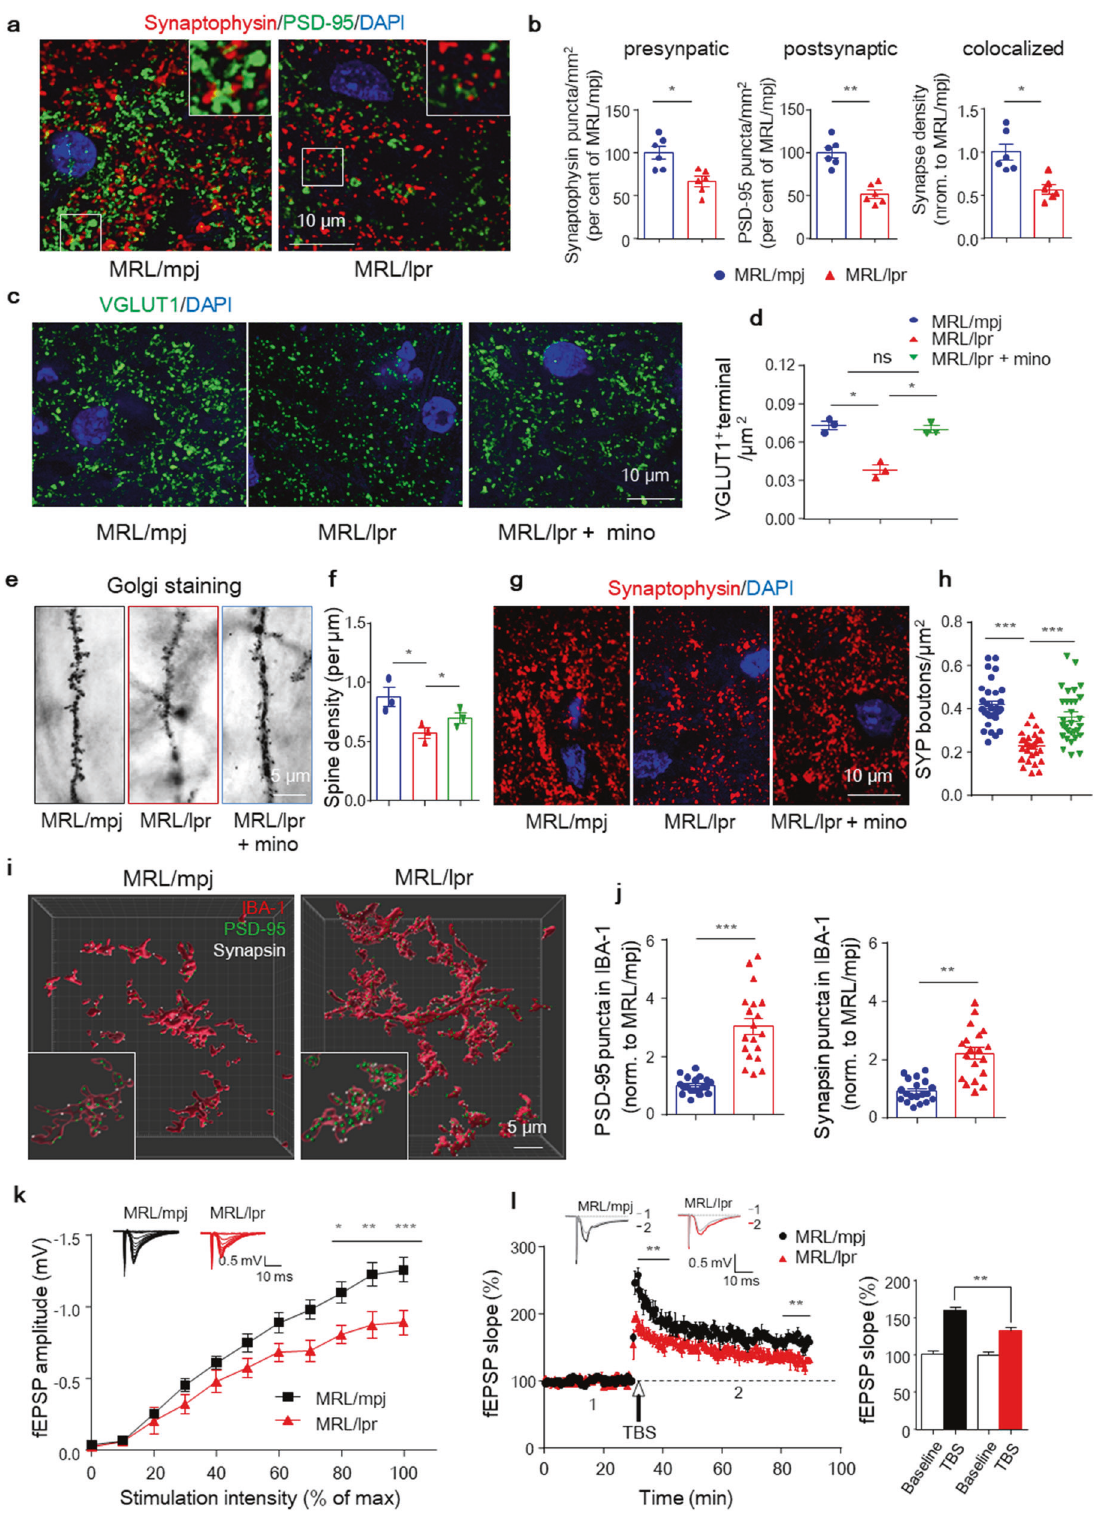
classes of microglial-mediated phagocytosis (KEGG terms ‘ Phago- some ’ and ‘ Protein digestion and absorption ’ , Fig. 2b and Supplementary Fig. 3d) and the classical complement pathway (KEGG term ‘ the complement and coagulation cascades ’ , Fig.